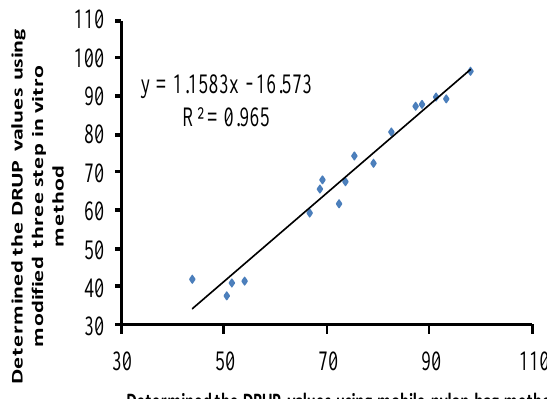
Figure 5. Predicted analysis between MNB observed values and MTS observed values in all the samples. DRUP, digestibility of rumen undegradable protein; MNB, mobile nylon bag method; MTS, modified three-step in vitro method.